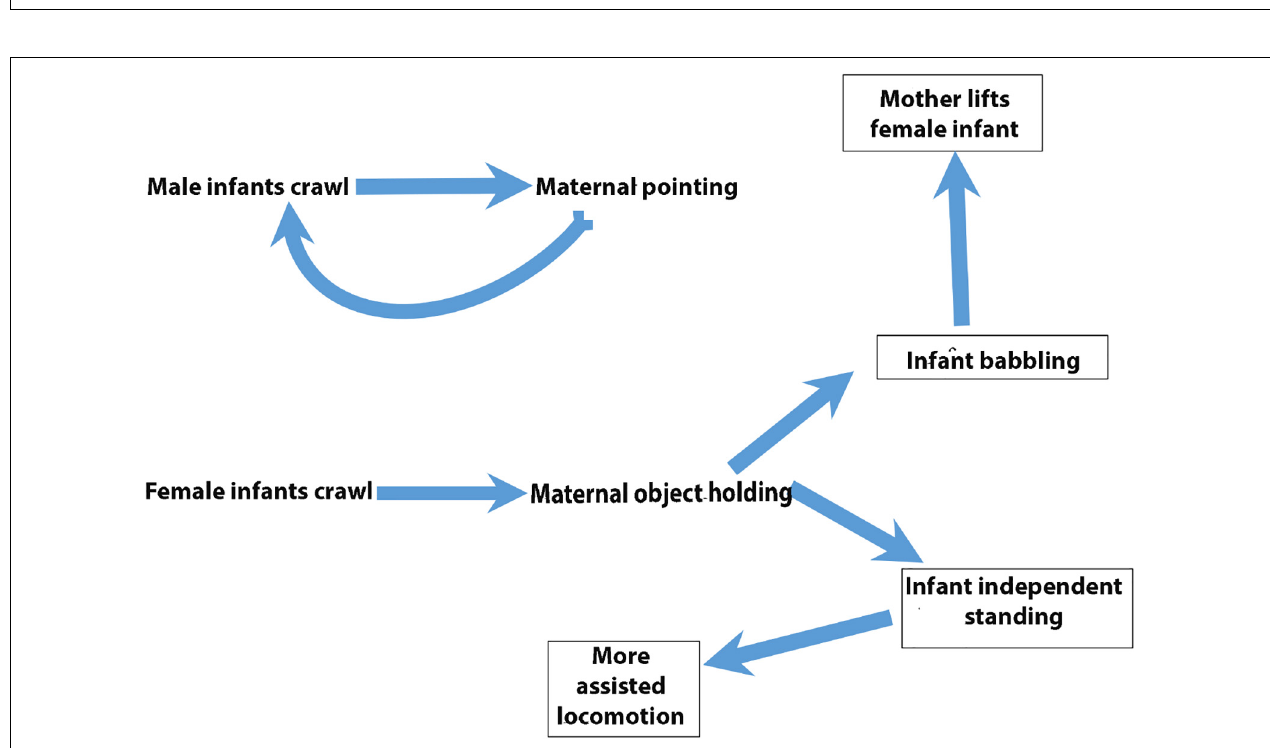
FIGURE 6 | Relationships among behavioral codes. Cartoon of relationships among behavioral codes distinguished by vector-autoregressive and impulse-response modeling.